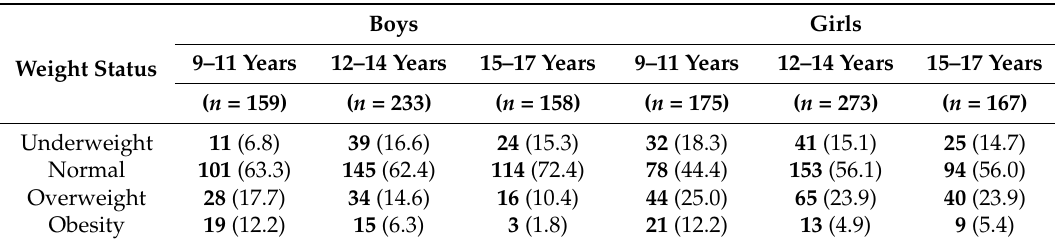
Table 1. Characteristics of school children by sex and